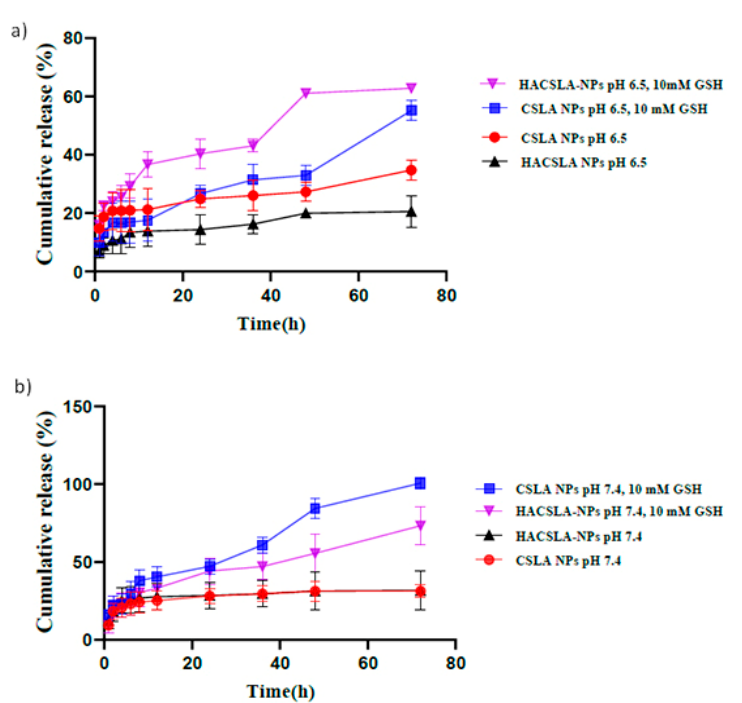
Figure 5. In vitro MT release profiles from ( a ) MT / CSLA-NPs, MT / HACSLA-NPs at pH 7.4 and ( b ) MT / CSLA-NPs, MT / HACSLA-NPs at pH 6.5 values and reduction conditions.